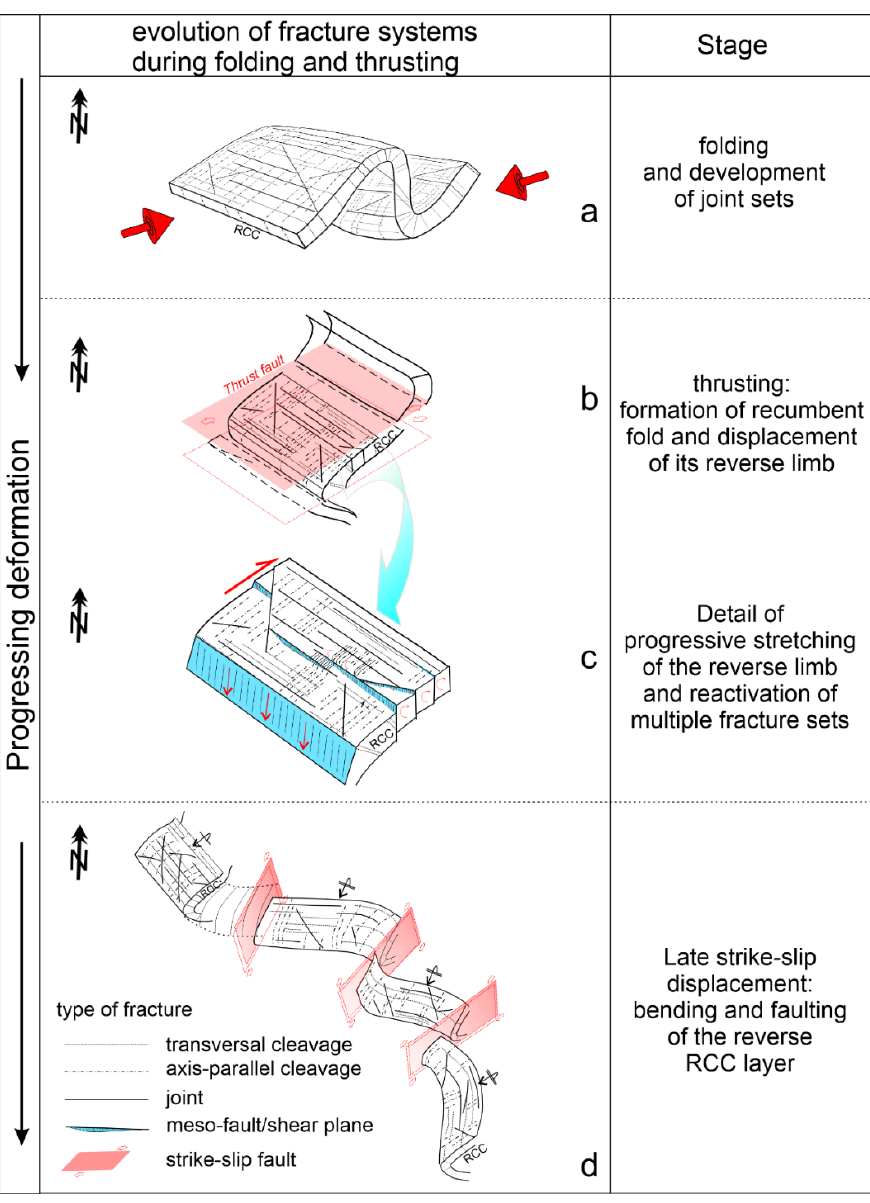
Figure 12. Synoptic structural geological sketch of the different stages for the progressive fold- and-thrust deformation recognized in the RCC. ( a ) Stage of folding and development of joint sets; ( b ) stage of thrusting; ( c ) detail of progressive stretching of the reverse limb and reactivation of multiple fracture sets; ( d ) Stage of late strike slip displacement. Cartoons are not to